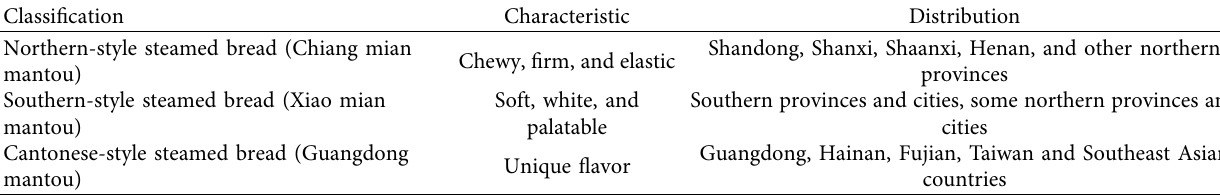
Table 3: Classification of Chinese steamed